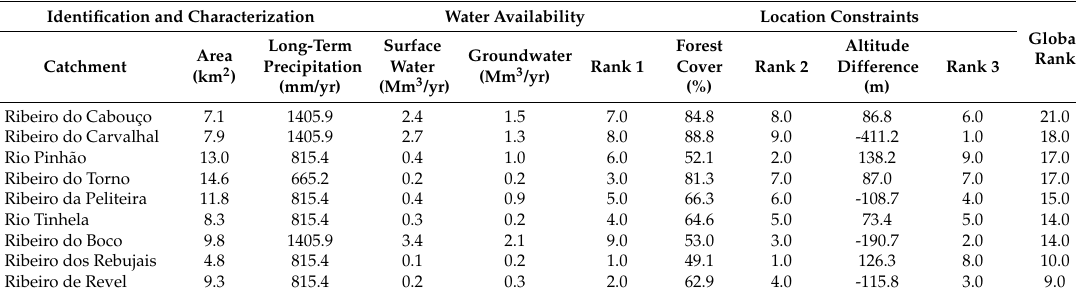
Table 2. Combined assessment of catchment suitability based on availability of surface water (Rank 1), percentage of forest cover (Rank 2) and altitude difference between catchment outlets and drinking water tanks located in the Vila Pouca de Aguiar and Bornes de Aguiar/Pedras Salgadas